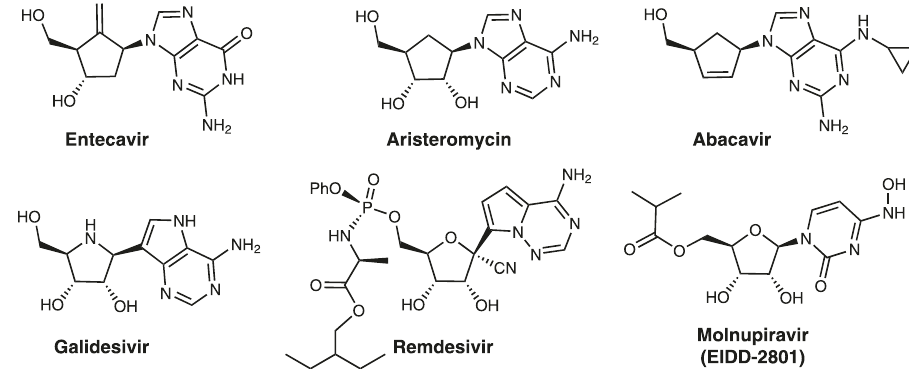
Fig. 1 Antiviral nucleosides analogs. Few examples of nucleoside analogs as commercially available antiviral